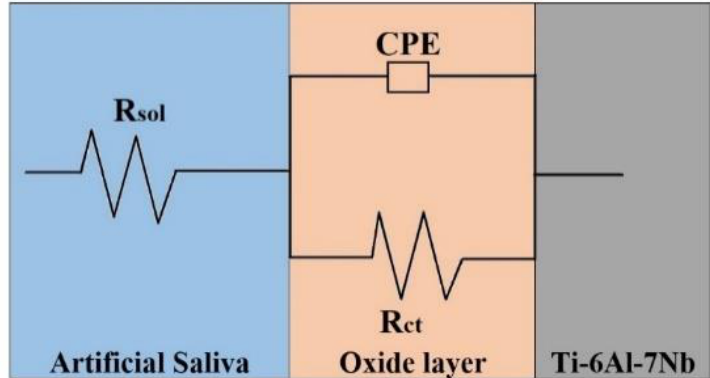
Figure 11. The electrical circuit used for the fit of experimental data.